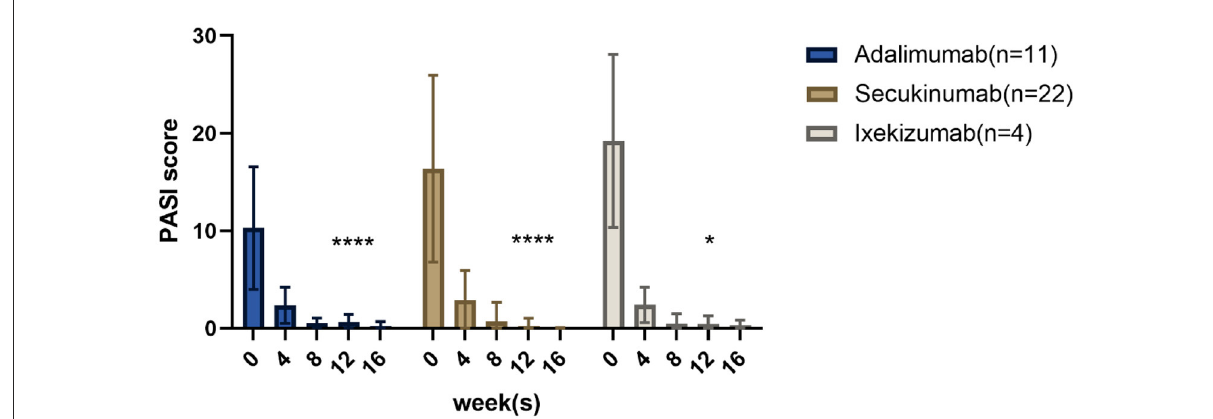
FIGURE1 Results after 16 weeks: PASI scores of children with psoriasis treated with three different biological agents. * p < 0.05; **** p < 0.0001.